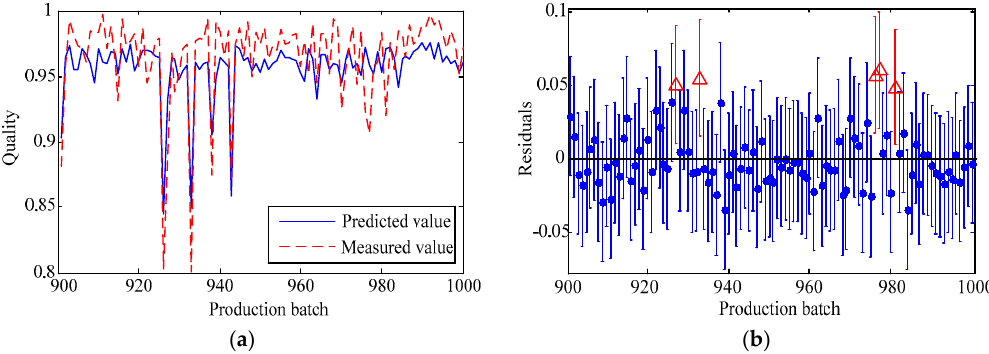
Figure 5. Prediction results of the MDRN model with 3-30-30-1 of Case 1: ( a ) plots the comparison with the measured and the predicted values, and ( b ) shows the residual error